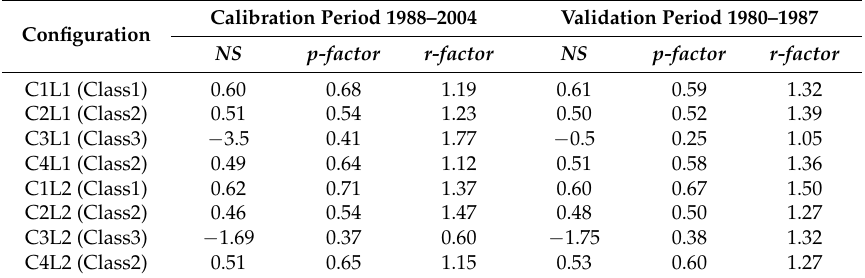
Figure 5. Comparison of simulated and observed discharge values in the O7 outlet (Figure 1) during the calibration and validation periods. The green shaded region is the 95PPU band. The best simulation (i.e., the simulation with the highest bR 2 ) is shown by the blue line. Table 4. The performance of the eight configurations during the calibration and validation periods.